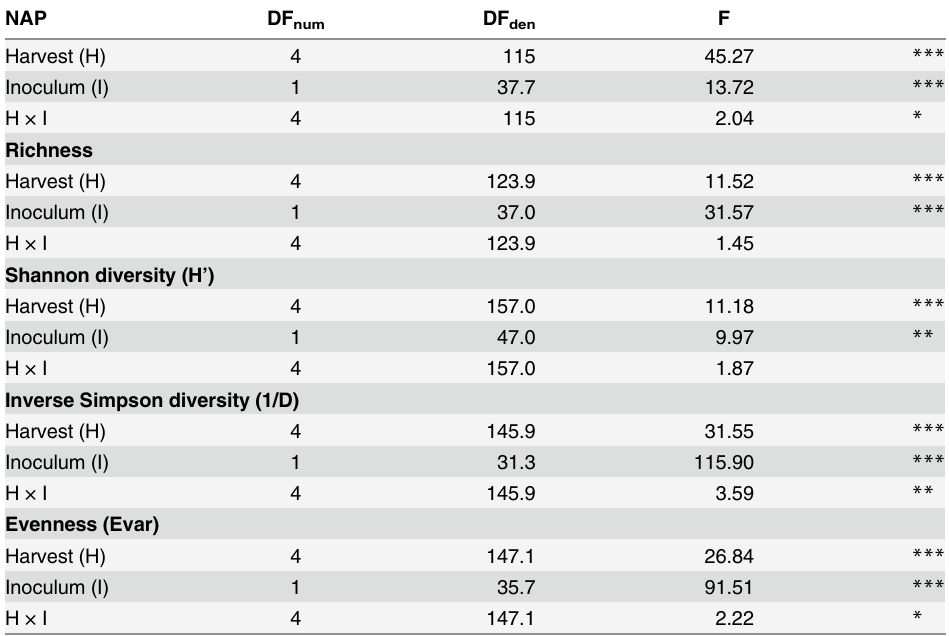
Inoculum refers to the inoculum treatment (unaltered versus sterilized) and harvest to the harvest period (at 11, 22, 33, 44 and 55 weeks). The response variables are the net aboveground productivity (NAP), realized richness, Shannon diversity, inverse Simpson diversity, and